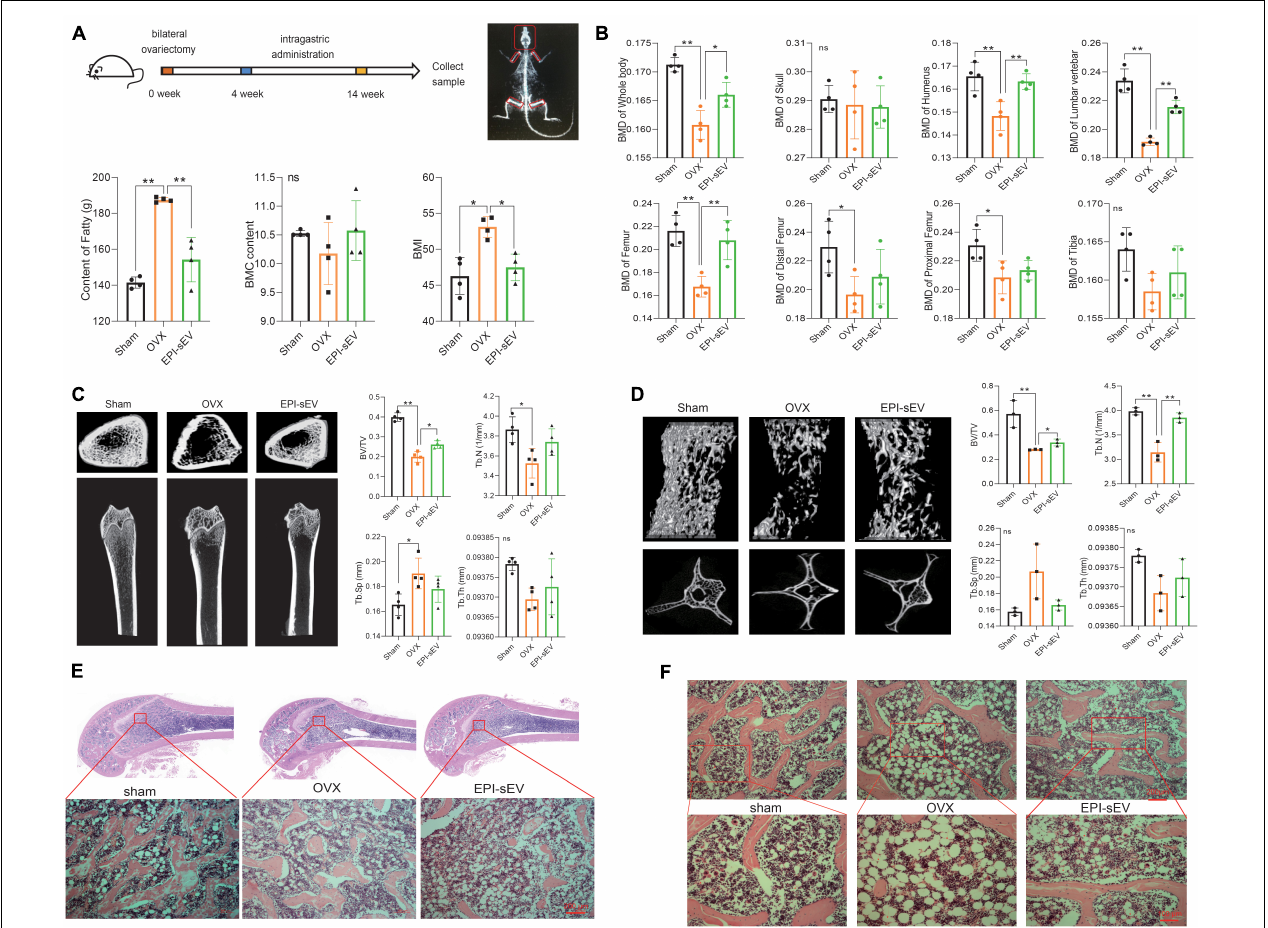
FIGURE 3 | EPI-sEV stimulates bone formation and microstructure restoration in OVX rats. (A) The BMC, BMI, and the content of fat in the different groups ( n = 4); the raw data represented the replicate value. (B) The BMD of different positions in the different groups ( n = 4); the raw data represented the replicate value. (C) Micro-CT image and quantitative CT analysis in the distal femur ( n = 4); the raw data represented the replicate value. (D) Micro-CT image and quantitative CT analysis in the lumbar vertebrae ( n = 3); the raw data represented the replicate value. (E) HE staining in the femur; scale bar: 200 µ m. (F) HE staining in the lumbar vertebrae; scale bar: 200 or 100 µ m. * p < 0.05, ** p < 0.01; ns, non-significant; analyses were performed twice and obtained comparable